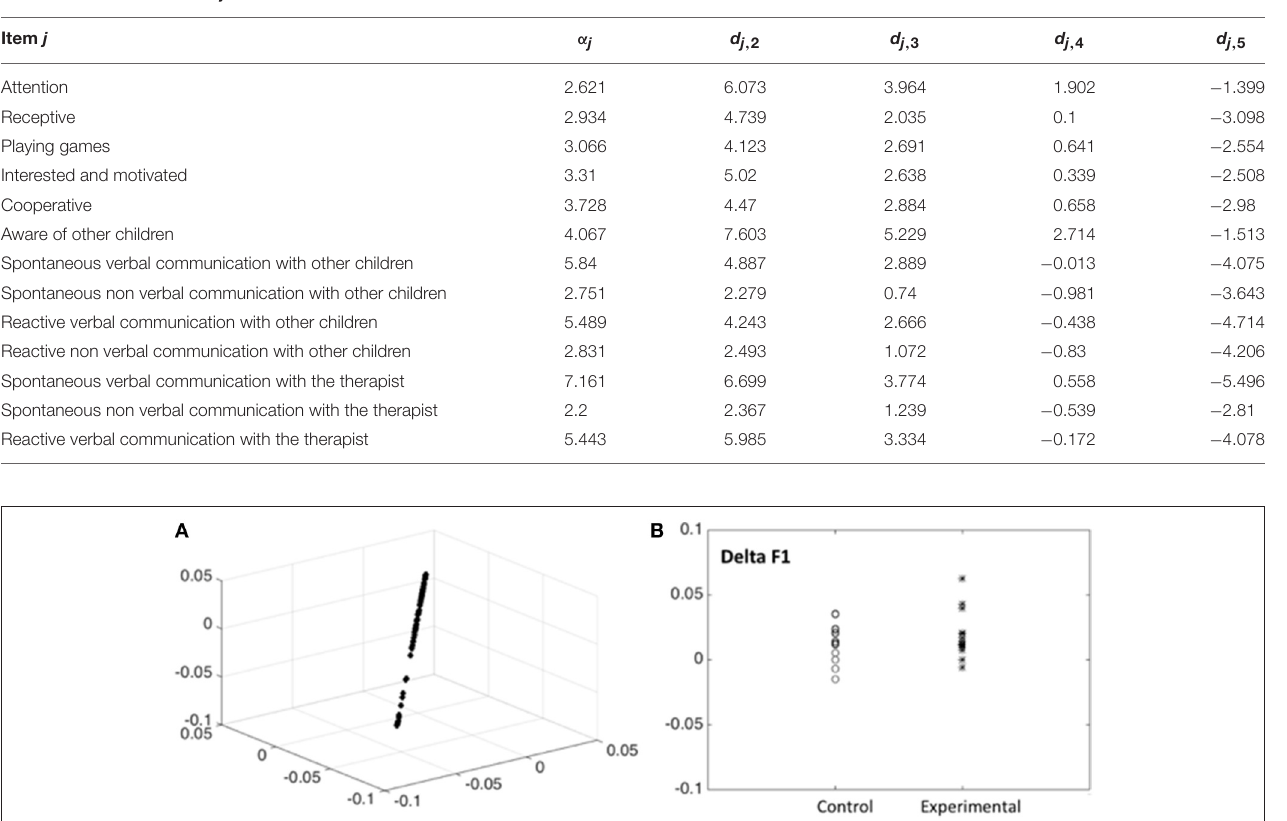
FIGURE 3 | Intrinsic dimensionality of the behavioral data. (A) Scores for the 13 scores with good discrimination for all subjects are shown, plotted on the first 3 dimensions of the Laplacian Eigenmaps representation (Belkin and Niyogi, 2002). Note that the scores are all concentrated around a straight line indicating that a single outcome score (F1) for children is adequate. (B) Differences between post—pre scores (Delta F1) for the outcome measure (Neuropychological status) F1 shown for children from the control and experimental group. Note that the experimental group has, on the average, higher scores. Tables 3 , 4 , 5 substantiate the statistical significance of this graph.